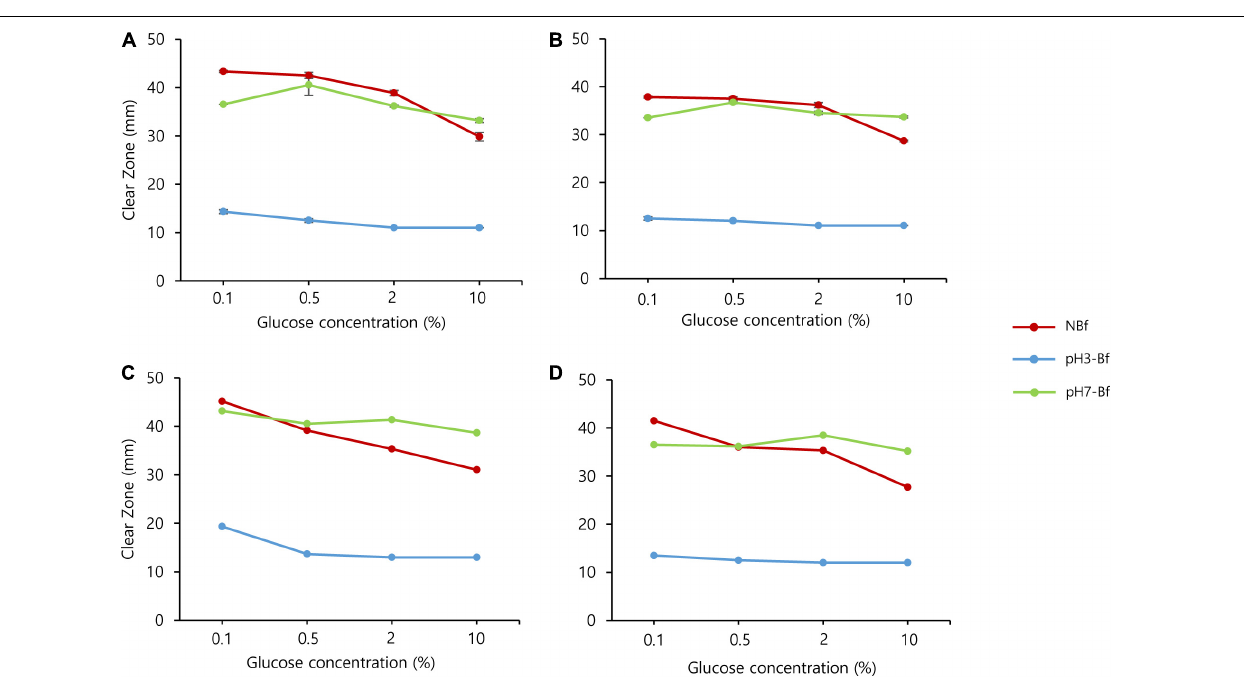
Frontiers in Microbiology |